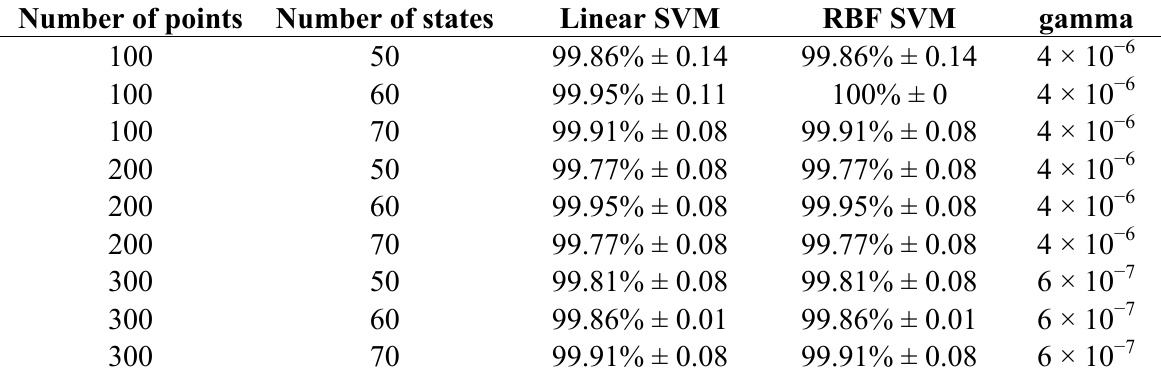
Table 5. Success rates for DKMM transformation and SVM with 144 users.